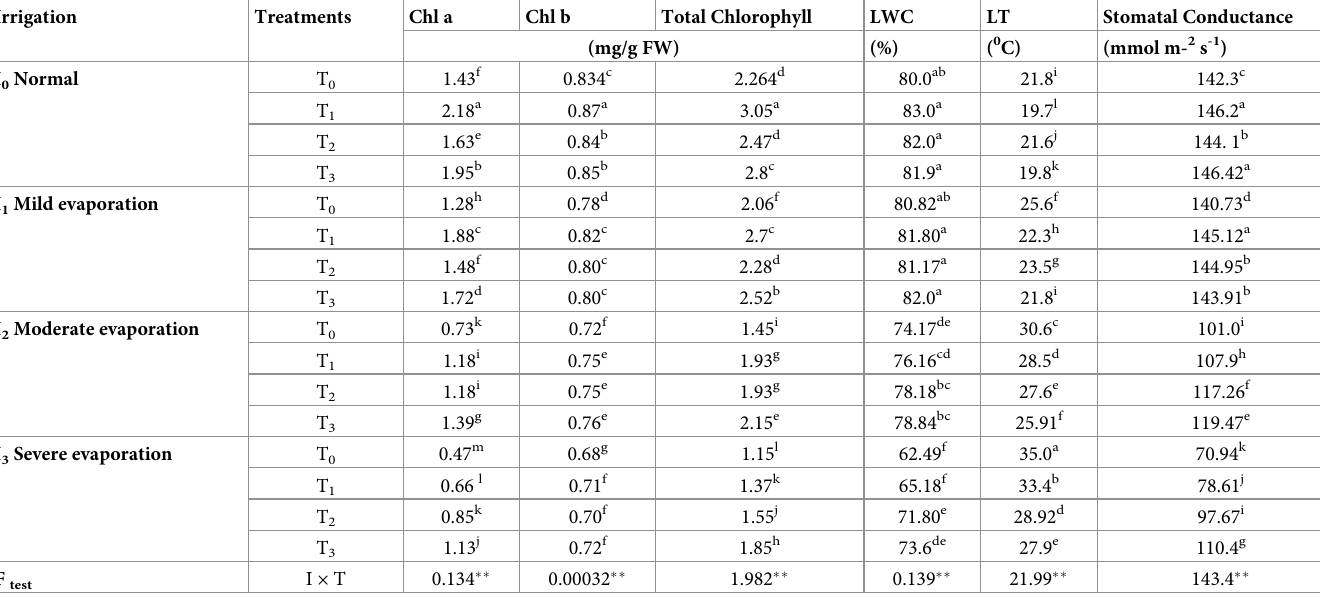
Table 4. Variation in physiological attributes of canola with chemical fertilizers and plant growth regulators under different water regimes.